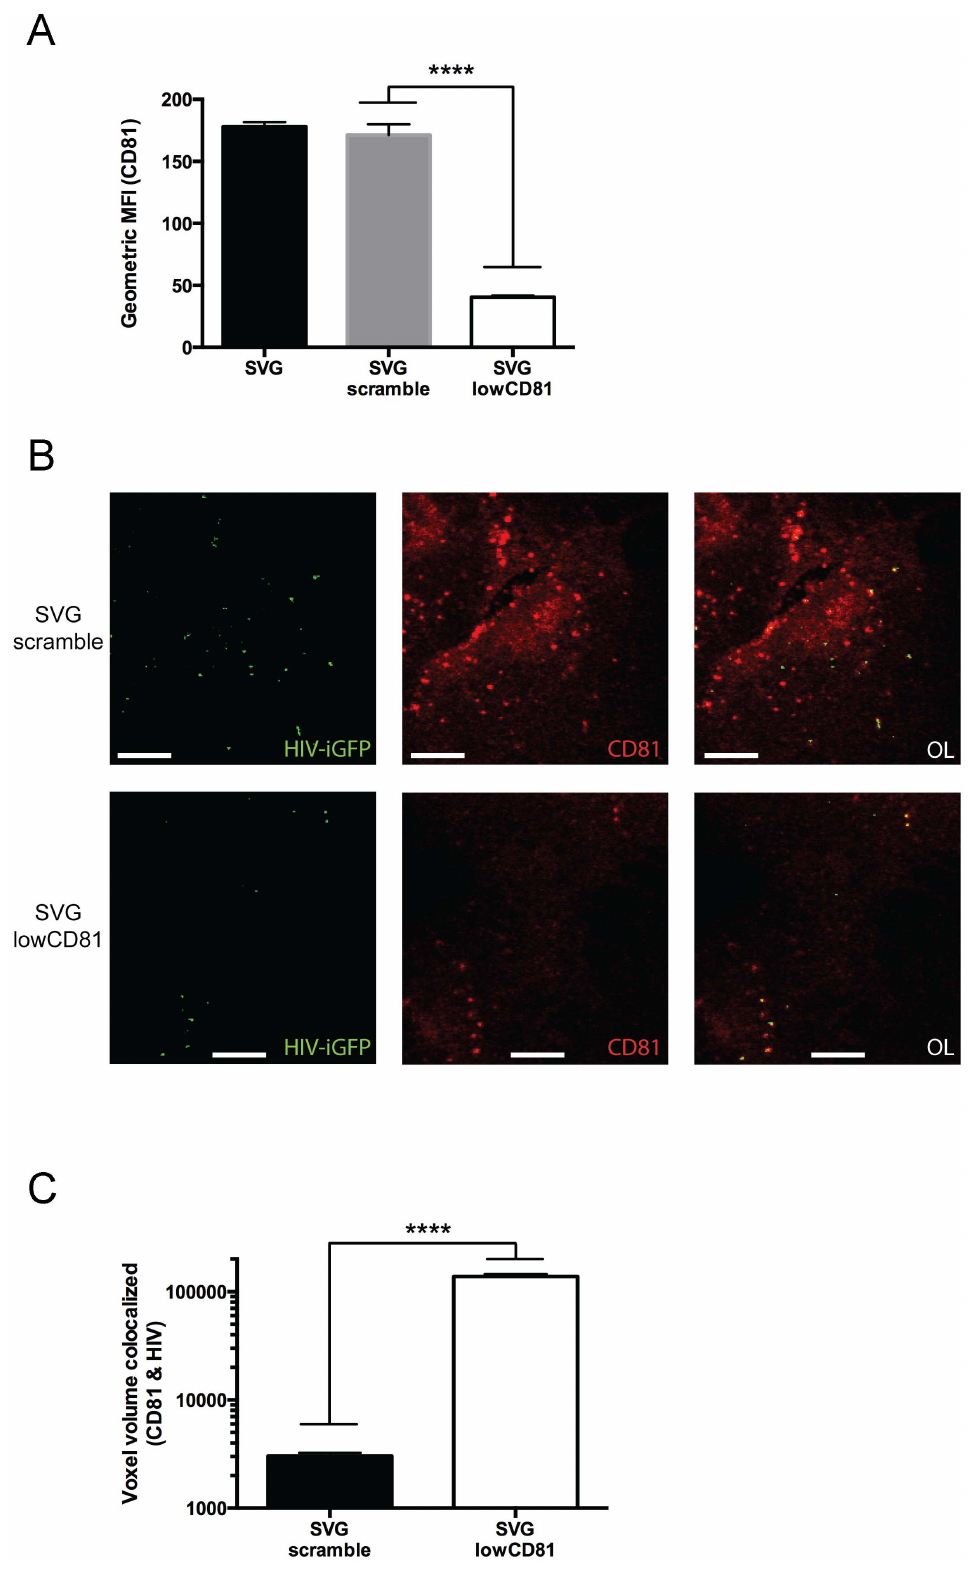
Figure 3. CD81-HIV-1 association is maintained when CD81 expression is reduced. (A) CD81 expression levels of the parental SVG cell line, SVG-scramble (cells treated with shRNA-scramble) and SVG-lowCD81 (cells treated with shRNA-CD81) cells as determined via FACS analysis. The data are expressed as mean values and error bars represent standard deviation. (B) SVG-scramble and SVG-CD81 cells were infected with an EGFP content- labelled HIV-1 YU2 virus (green) and samples were harvested at 135 mins post-infection. Cells were stained with the vesicle marker CD81 (red). Panels